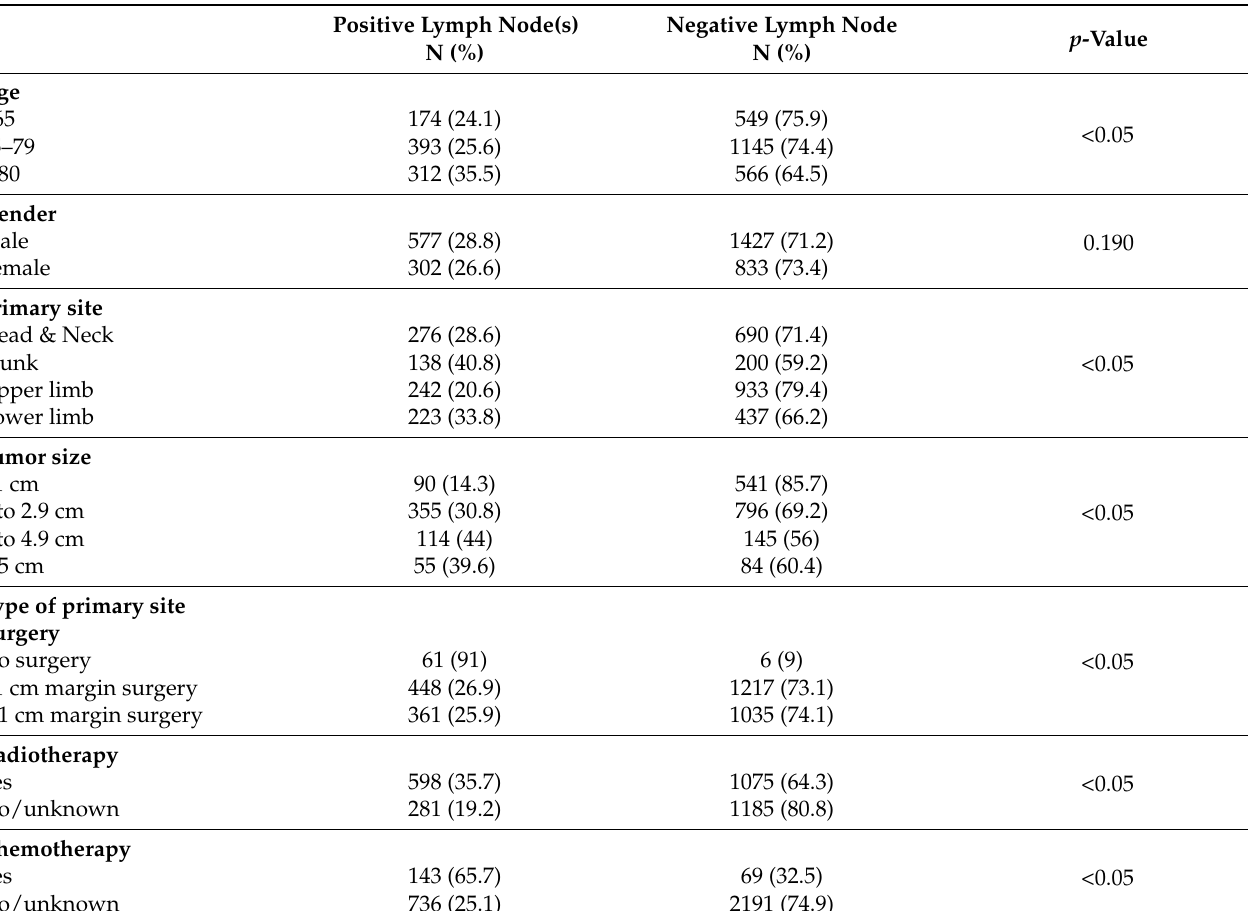
Table 2. Lymph node positivity in SLNB/LN sampling according to demographic, tumor and treatment patterns.